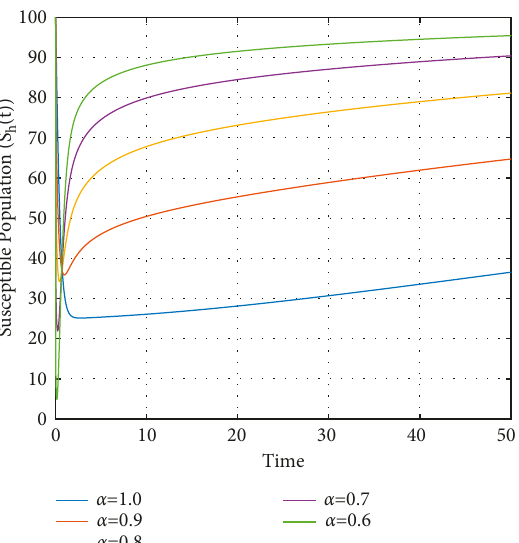
Figure 4: The graph visualizes the temporal dynamics of the susceptible for long run against various value of ( σ ) , while the value of epidemic parameters are: Λ � 0 . 4, β � 0 . 06, and α � 0 . 06. We also used the initial population sizes: ( 100 , 90 , 80 , 70 , 60 ) η 2